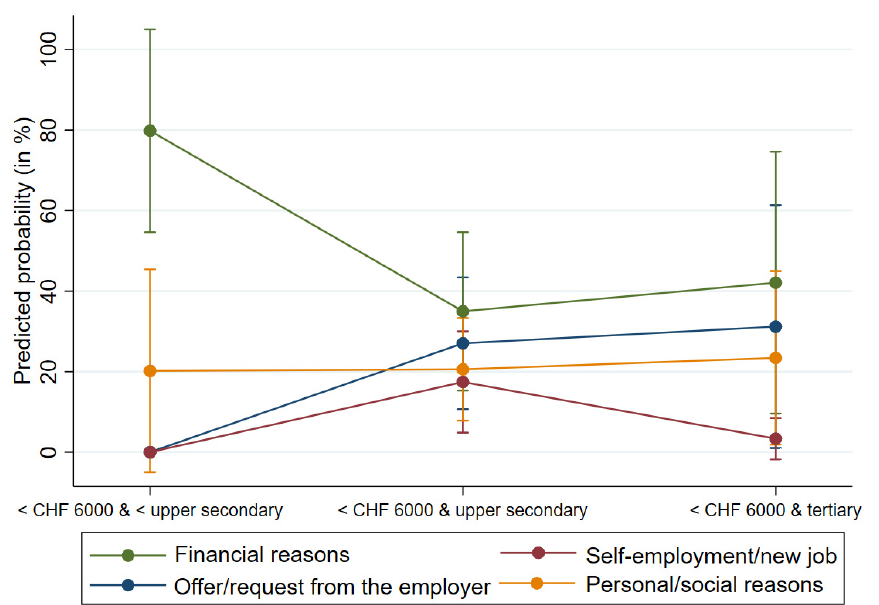
Figure 2. Predicted probabilities and 95% confidence intervals for the lowest level of income and for all levels of education, based on a multinomial logistic regression on the reason for working beyond the SRA.